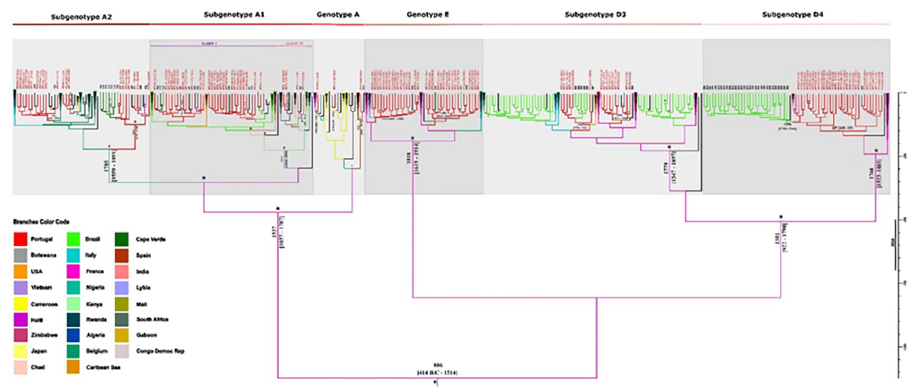
Fig 1. Bayesian maximum clade credibility tree of HBV partial polymerase gene sequences. The colored internal branches represent the locations of the parental nodes (based on node latitude and longitude coordinates), as assigned by continuous Bayesian phylogeography (color code below the tree). Each branch color allows to perceive the dispersion patterns of each genotype from a node (location) to another. Branches and tips of Portuguese isolates are labeled in red. External branches labeled with black initials represent the countries to where Portugal exported HBV strains (BR-Brazil; CM-Cameroon; CU-Cuba; CV-Cape Verde; DE-Germany; FR-France; IN-India; IT-Italy; NL-Netherlands; NO-Norway; SP-Spain; US-United States of America). The external branches representing Portuguese speaking countries, Brazil and Cape Verde, are highlighted in light green and dark green, respectively. Collapsed branches (triangles) represent clades that are not of primary interest for the study and are too large for displaying in full. They are filled in black because they include isolates from different origins, being outlined with the color of the country that originated them. Within subgenotype A1, Clade I–A1 Asian/American clade is labeled with a purple line, while Clade II–A1 African Clade is labeled with a rose line. The scale on the right of the tree represents years before the last sampling time (2012). Tree is annotated with genotypes/subgenotypes emergence dates and dates of introduction in Portugal. Branches with a posterior state probability support � 0.9 are annotated with � . More information about control reference sequences (origin, date of collection and accession number) is available in S1 Fig as well as in S1 Table in support